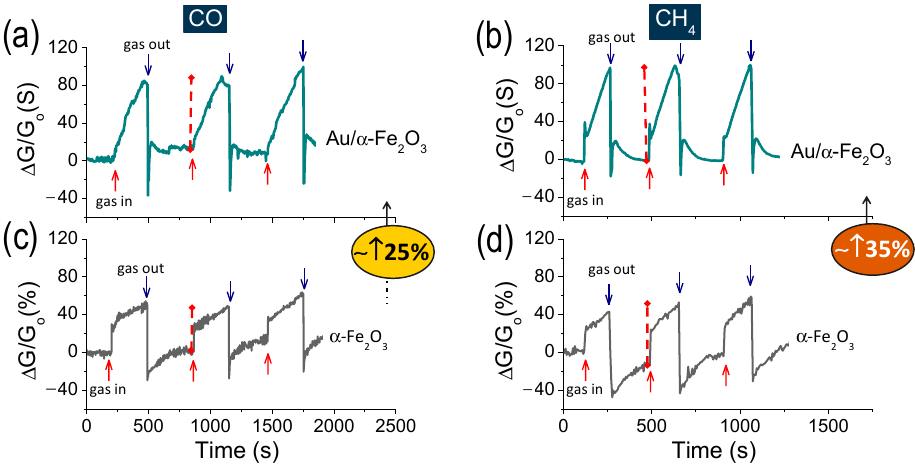
Figure 8. Gas sensor response curves for ( a , b ) Au/ α -Fe 2 O 3 bilayers deposited on STO(111) substrate at a substrate temperature for the Au growth of 250 °C and ( c , d ) bare α -Fe 2 O 3 thin film under ( a , c ) CO and ( b , d ) CH 4 atmosphere at room temperature. G 0 and G values correspond to the sensor conductance in air and specific gas atmosphere. The gas in to gas out difference in the Δ G/G 0 curves is used to determine the gas sensor sensibility. A red bar is represented as an example in each case.